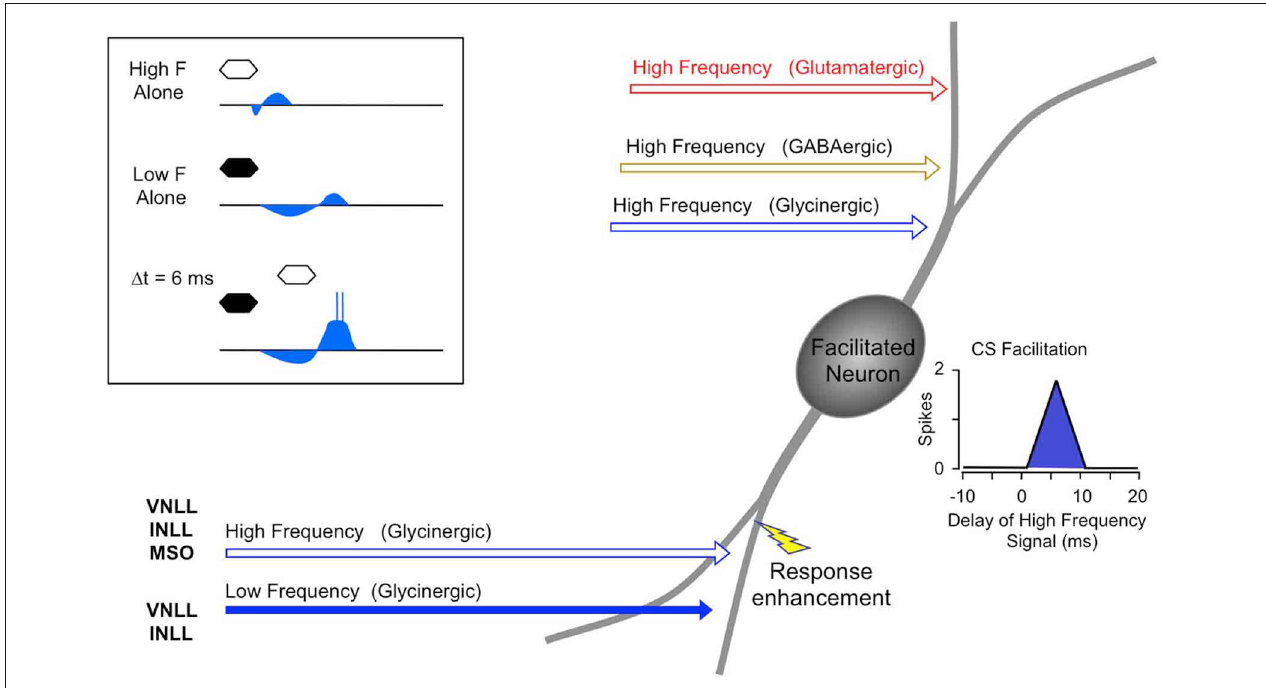
FIGURE 12 | Schematic diagram of mechanisms and circuitry underlying combination-sensitive facilitation in IC. Inset shows hypothesized mechanism of post-inhibitory rebound. Neuron receives a variety of high frequency inputs tuned to its ChF ( upper right ) that do not